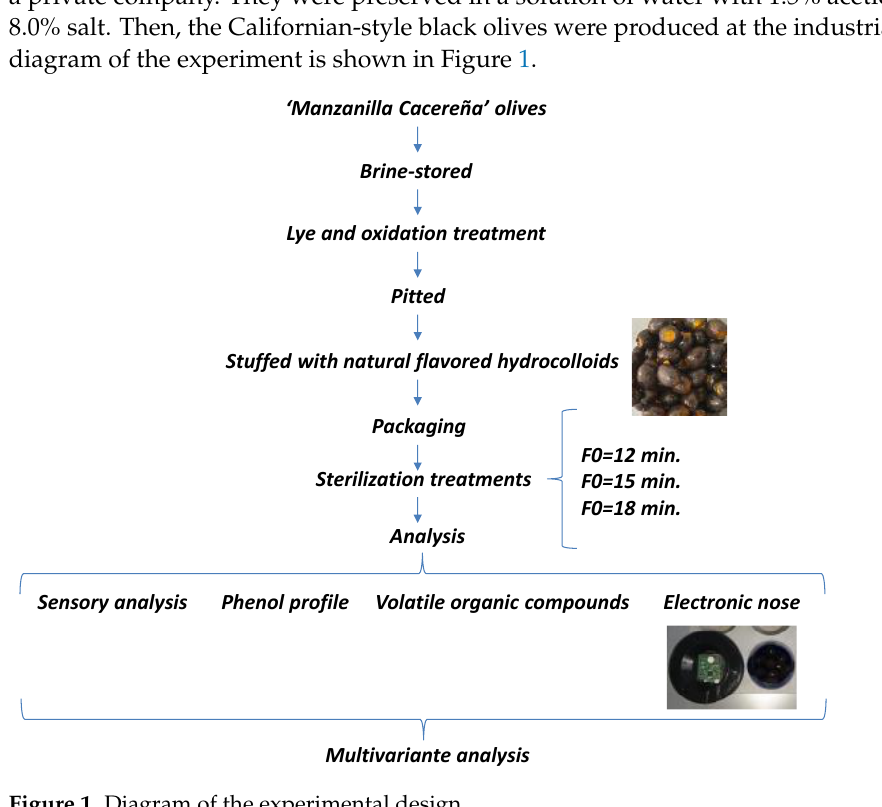
Figure 1. Diagram of the experimental design.